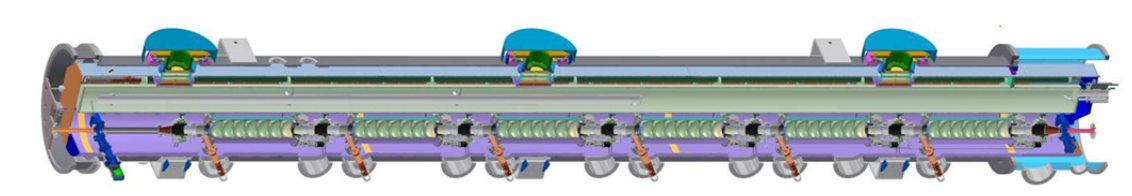
Figure 3. Layout of the CBETA cryomodule with six 7-cells cavities. The overall length is about 9